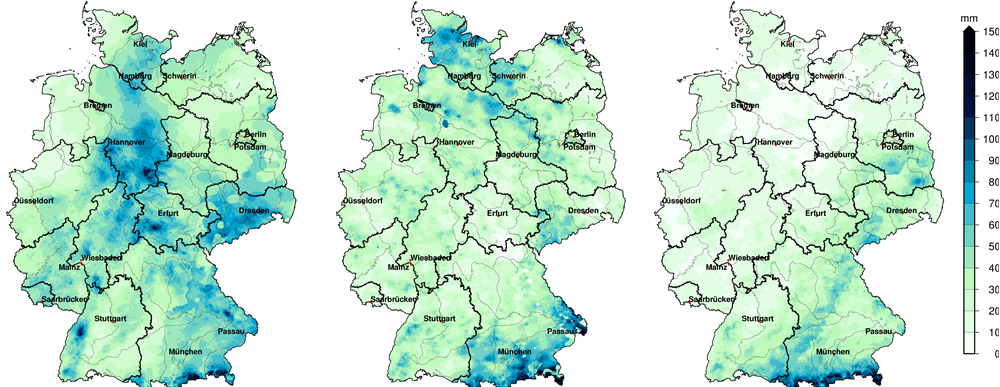
Figure 7. Antecedent precipitation index (API) over 30 days for the floods in June 2013 (left), August 2002 (middle) and July 1954 (right). See text for further details.